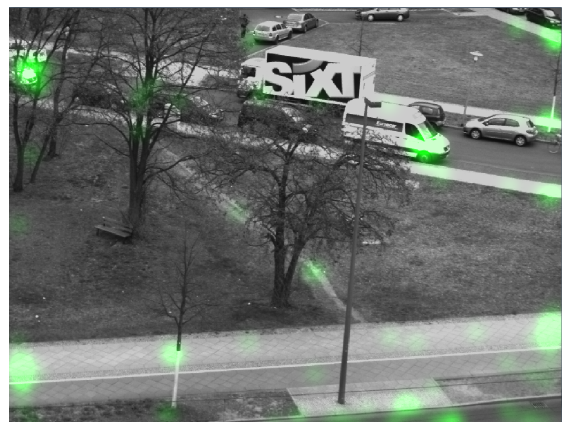
Figure 4: Example of generated entry zones within 22000 frames with 166 used